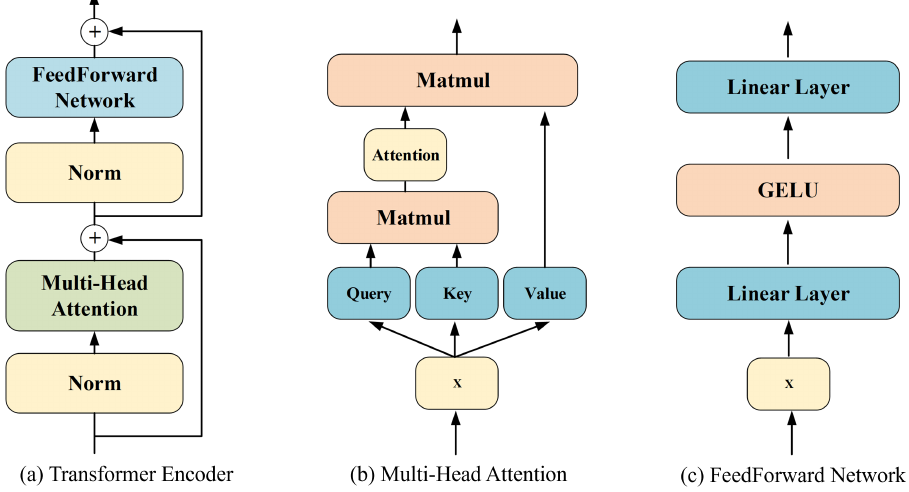
Figure 2. Structure of the transformer encoder. ( a ) The transformer encoder mainly consists of a multi-head attention module, a feedforward network (FFN), and two residual connections. ( b ) The multi-head attention first projects the input x into three vectors of the same shape, which are called the query, key, and value. The module then calculates the similarity coefficients between the query and the key vector. The similarity values are used as attention scores. The attention scores are further used to calculate the weighted sum of the value vector. ( c ) The FFN expands the input x into a higher dim and squeezes it back using an MLP. A nonlinear layer such as GELU [58] is inserted between the two fully connected